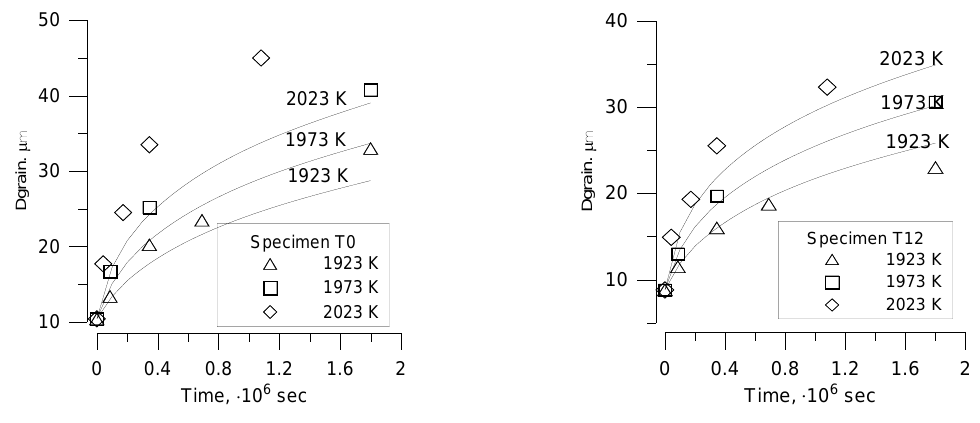
Figure 10. MFPR simulation of porosity evolution in Bourgeois’